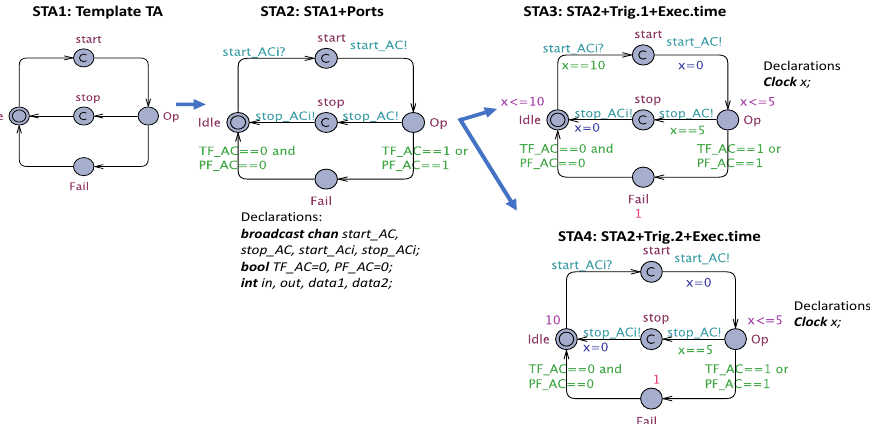
Figure 8. Step-by-step formulation of AC iSTA